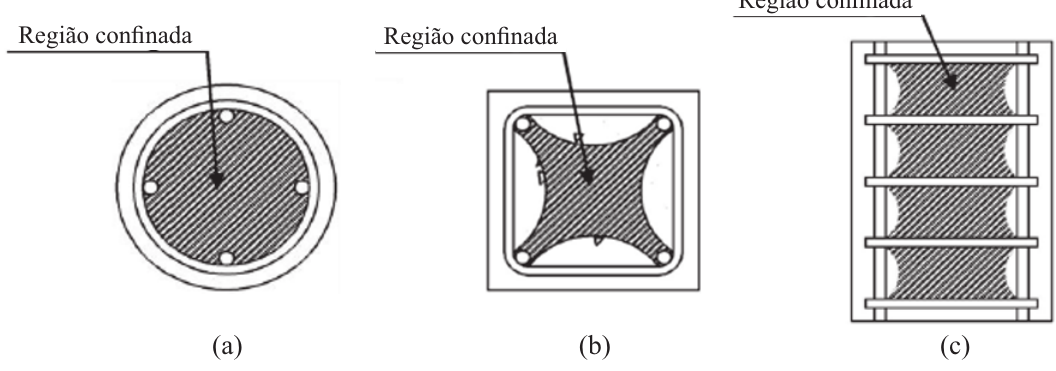
Região do pilar que sofre confinamento pelas armaduras transversais. (a) Seção transversal de pilares circulares confinados; (b) Seção transversal de pilares retangulares confinados; (c) Seção longitudinal de pilares confinados (confinamento entre